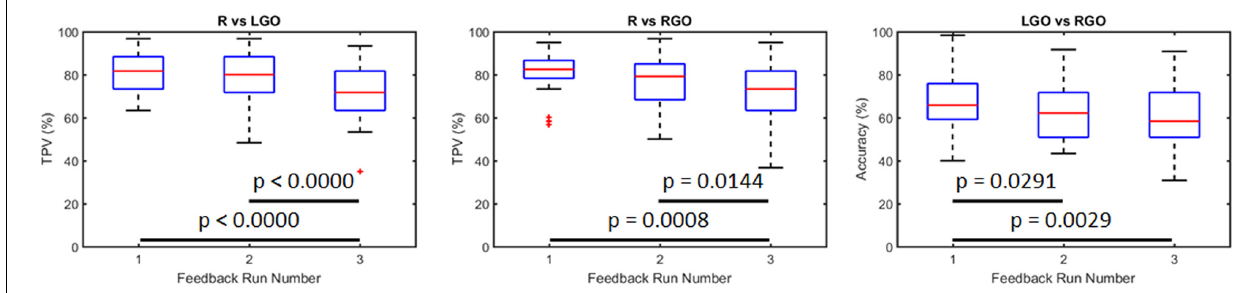
Frontiers in Neuroscience |